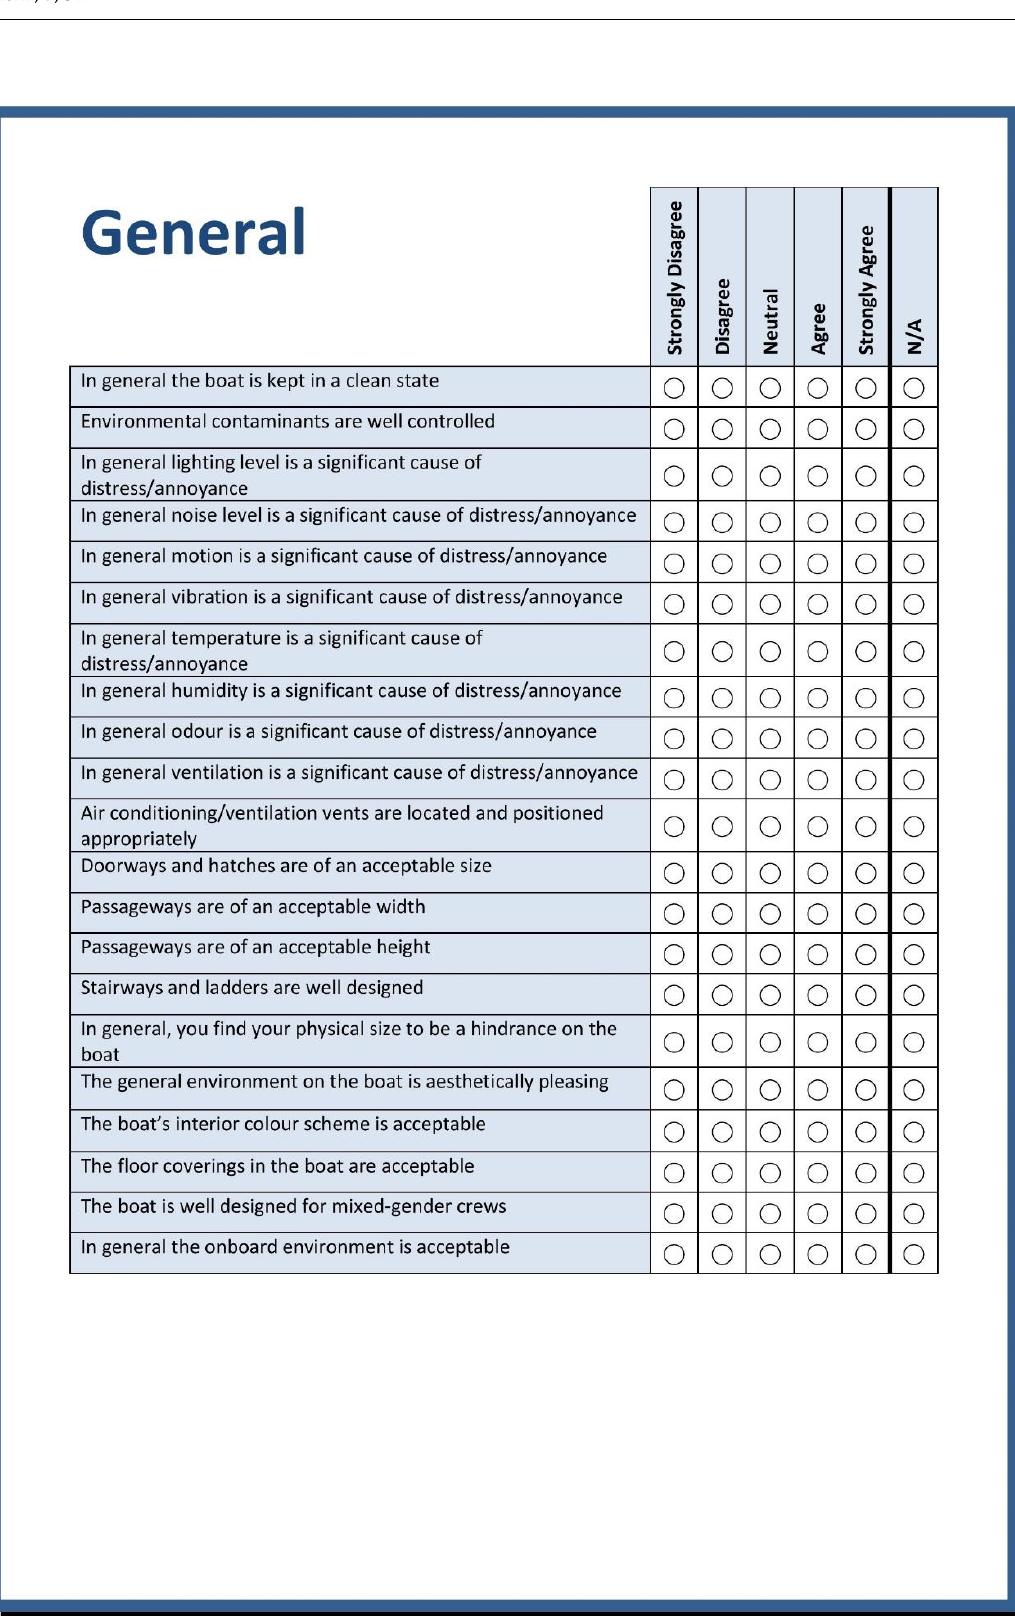
Figure A14. The Submarine Habitability Assessment Questionnaire (continued).